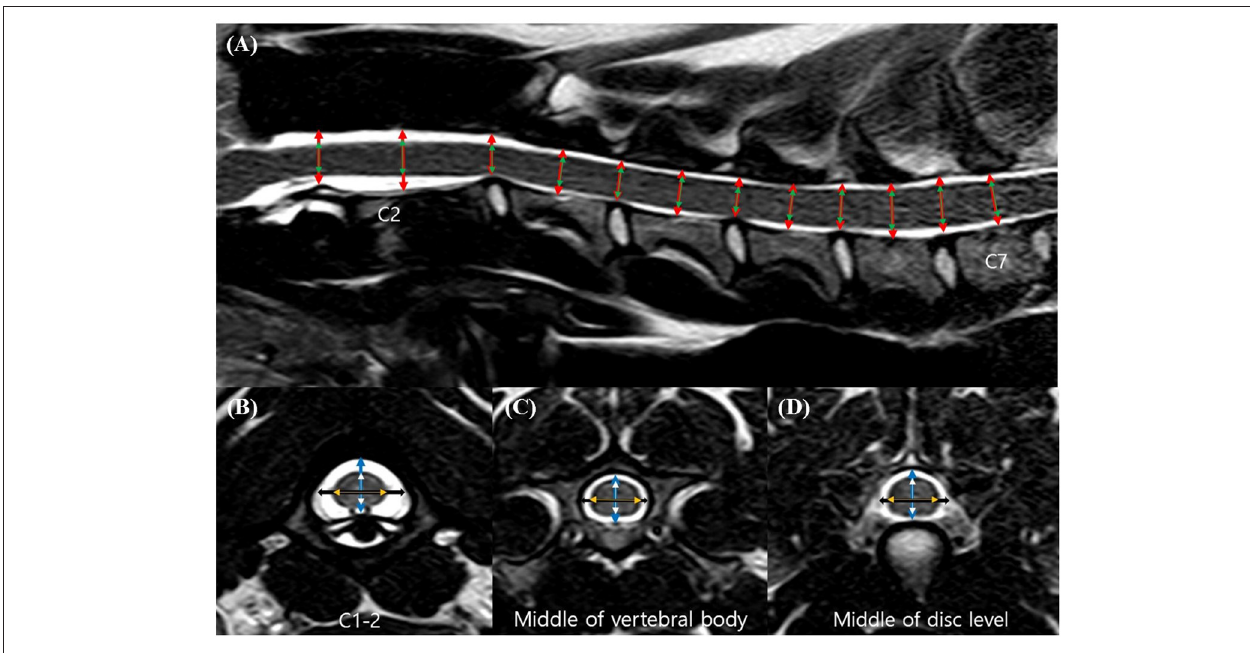
FIGURE 1 | Sagittal (A) and transverse (B–D) T2-weighted magnetic resonance (MR) images. Sagittal location of the measurements: the height of the spinal canal ( red arrows ) and the height of the spinal cord ( green arrows ). Transverse location of the measurements: the height of the spinal canal ( blue arrows ), the height of the spinal cord ( white arrows ), the width of the spinal canal ( black arrows ), and the width of the spinal cord ( orange arrows ).